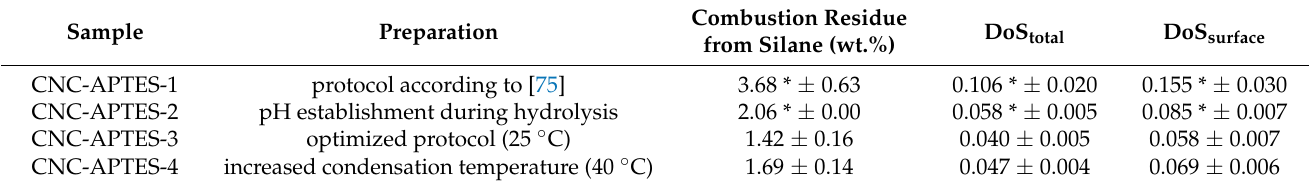
Table 2. DoS of APTES on CNCs for different synthesis protocols.